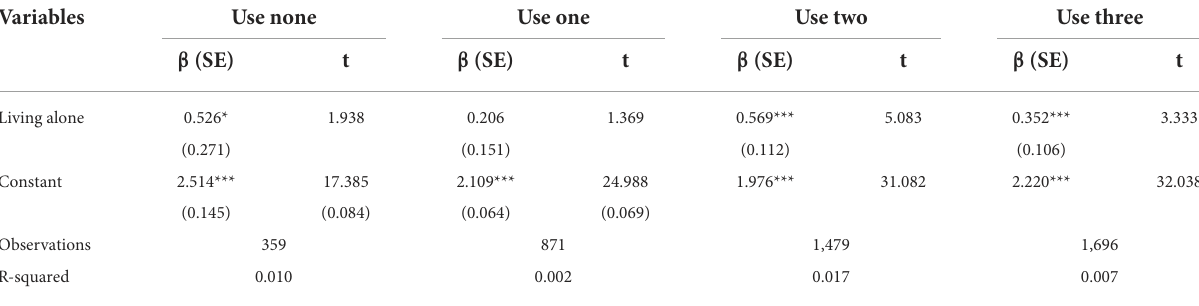
TABLE 7 Effect of the live alone on mental health, by EWP.